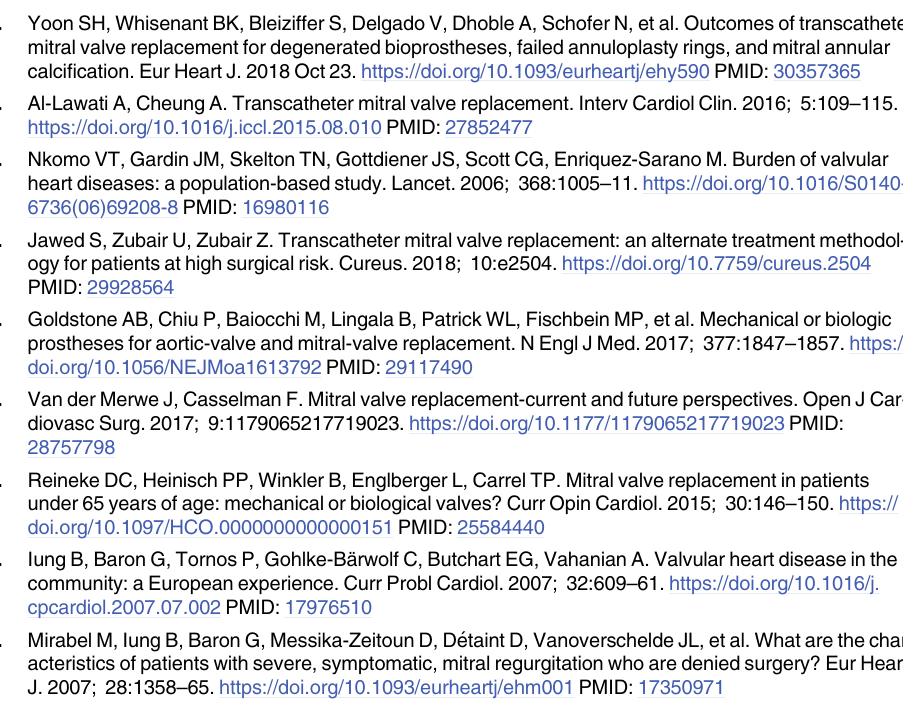
S2 Fig. Incidence of bioprosthetic mitral valve replacement among COPD and non-COPD patients in Spain 2001–2015. S1 Table. Distribution according to study variables of propensity score–matched COPD and non-COPD patients who underwent a mechanical or bioprosthetic surgical mitral valve